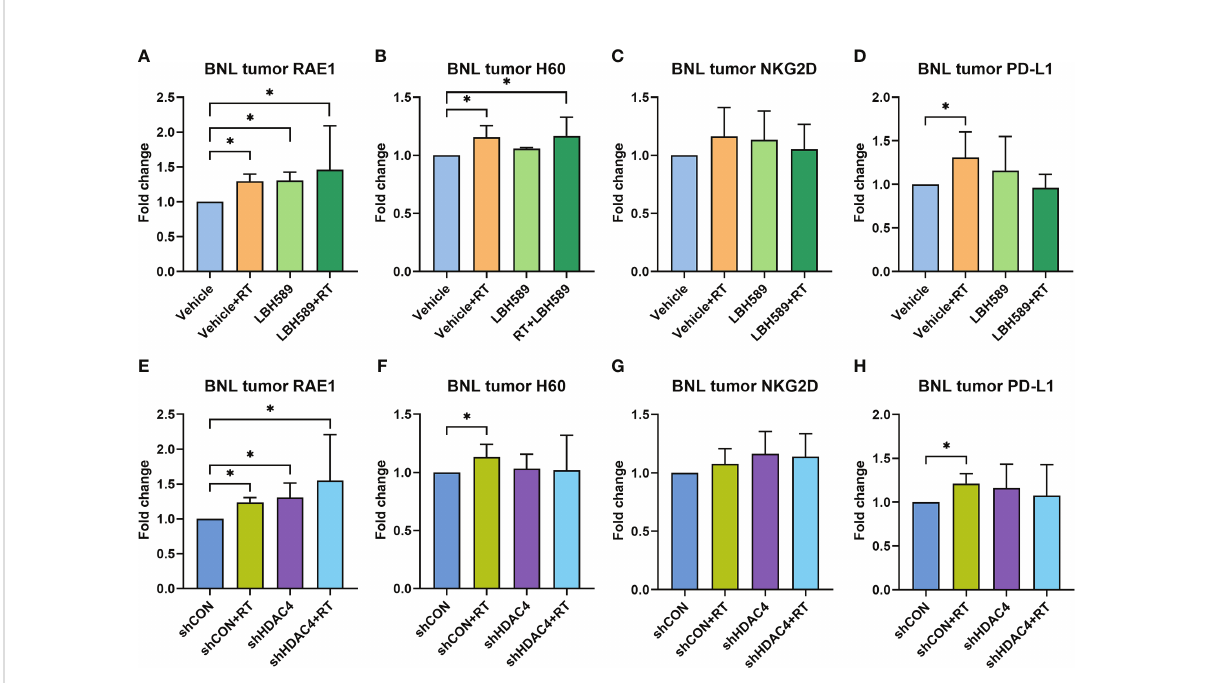
FIGURE 5 Effect of HDAC inhibitor LBH589 and/or radiotherapy (RT) on tumoral surface expressions of NKG2D ligands (A) RAE1, (B) H60, (C) NKG2D receptor, and (D) immune checkpoint molecule PD-L1 in ectopic HCC allografts using wild-type BNL cells, as well as (E) RAE1, (F) H60, (G) NKG2D receptor, and (H) immune checkpoint molecule PD-L1 in allografts using HDAC4 shRNA knockdown (shHDAC4) BNL cells. The data represented the fold change compared with vehicle or vector-control shRNA (shCON) group. Error bars indicate SD, *P <